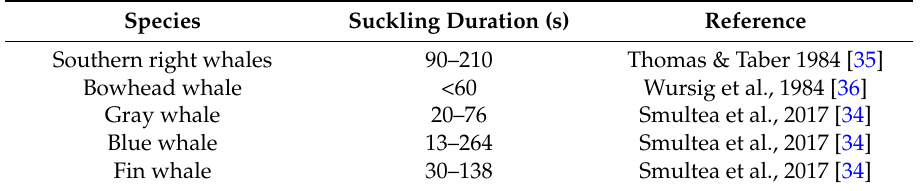
Table 2. Summary of suckling duration previously recorded during other large whale